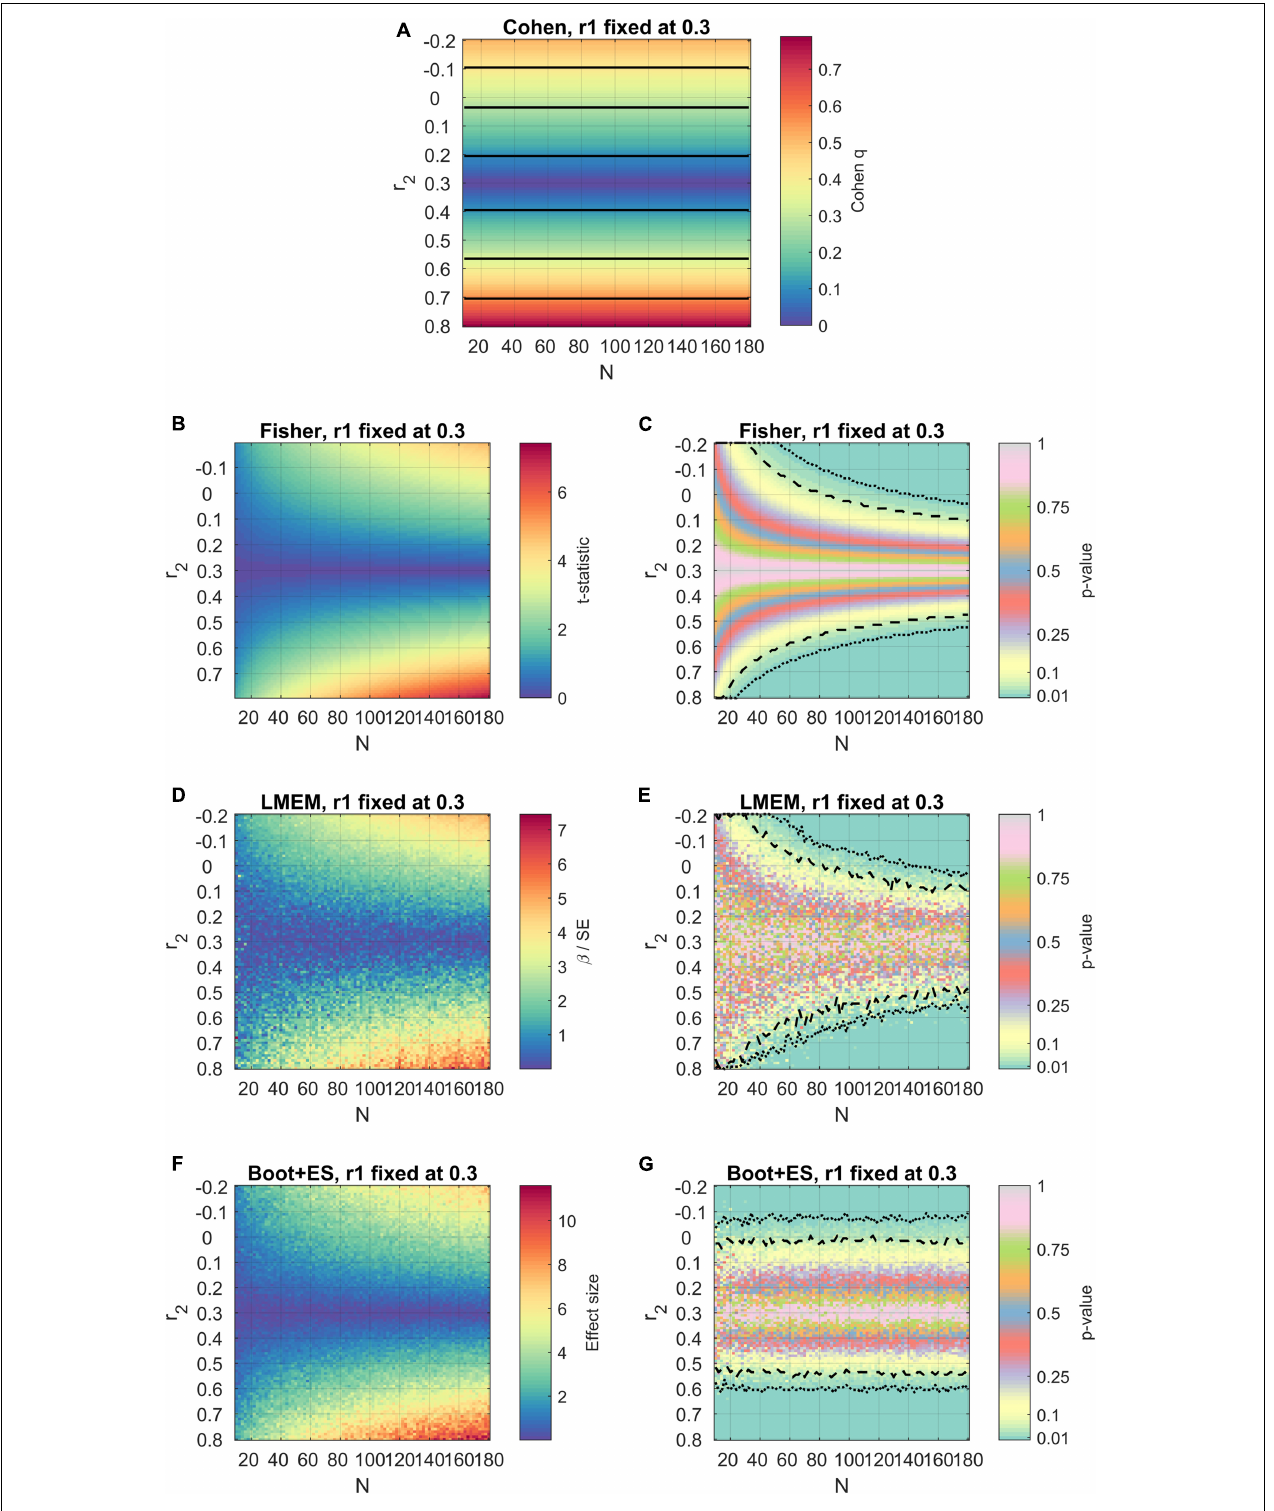
FIGURE 3 | Results of the simulations using the four methods, with the first value of correlation fixed to r 1 = 0.30. The axes, color scheme, and significance lines are the same as used in Figure 1 . (A) Cohen’s method. (B,C) Fisher’s method. (D,E) LMEM. (F,G) Bootstrap followed by effect size estimation.